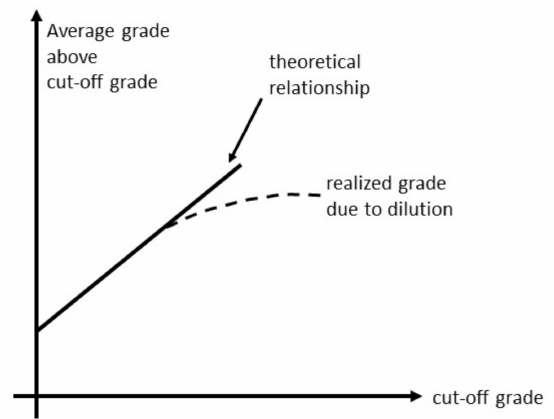
Figure 7. The theoretical relationship between cutoff grade and a grade above the cutoff grade, i.e., grade of run-of-mine (ROM) ore, according to Taylor (1972) [35] and David (1977) [36], and realized grade due to increasing dilution caused by raising the cutoff